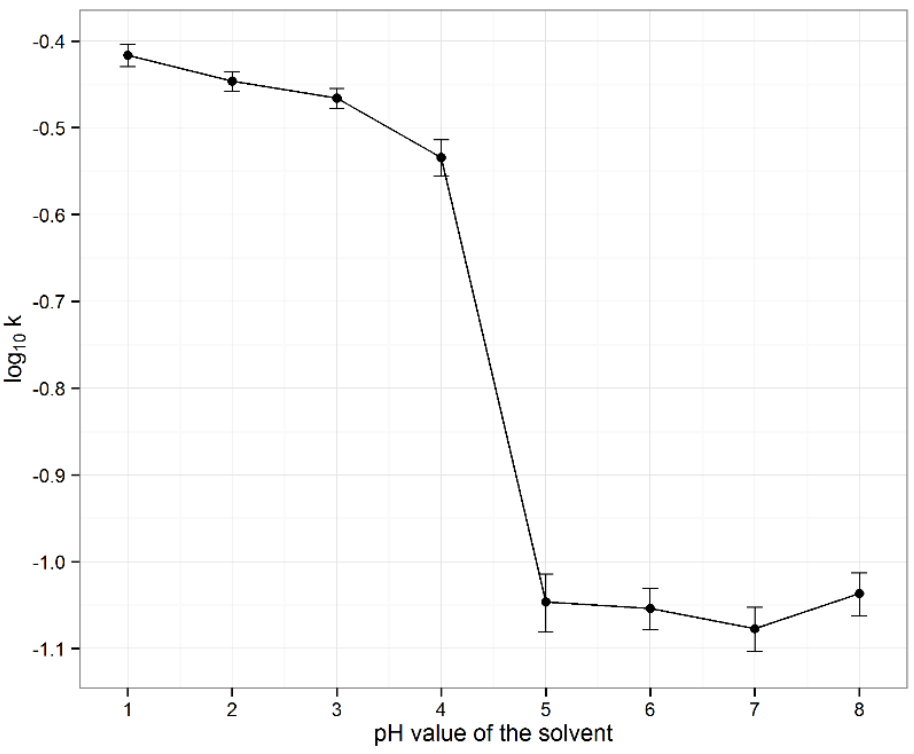
Figure 2. pH profile of vitamin D3 in aqueous solutions at 25 °C ( n = 3).